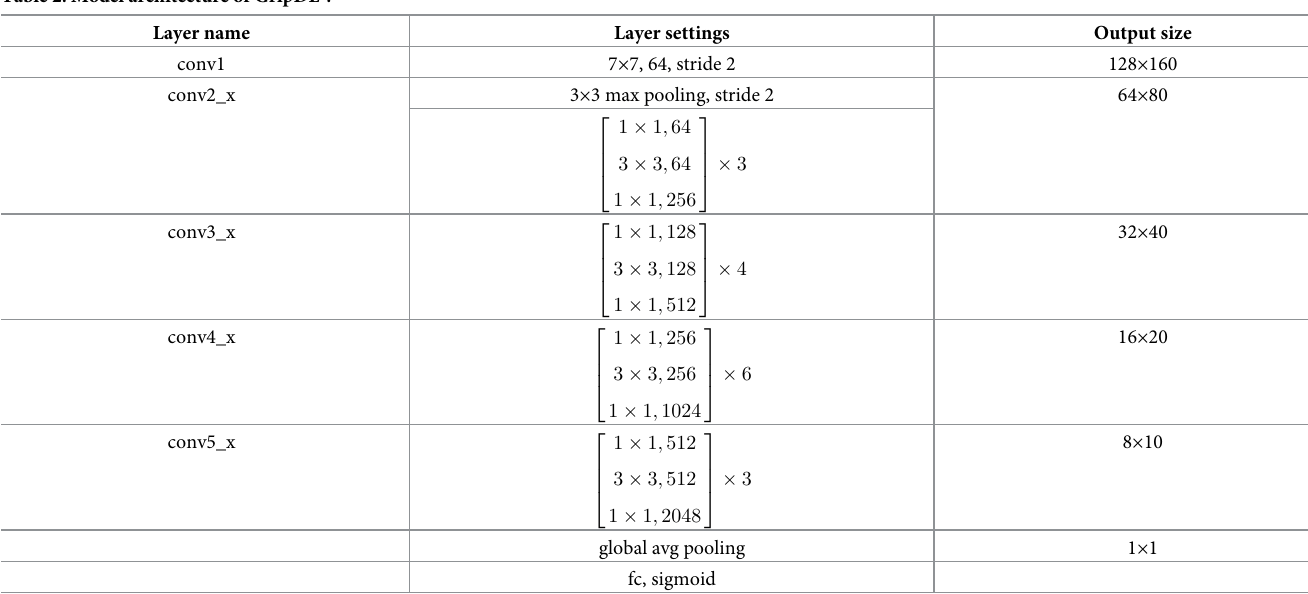
Table 2. Model architecture of GripDL a